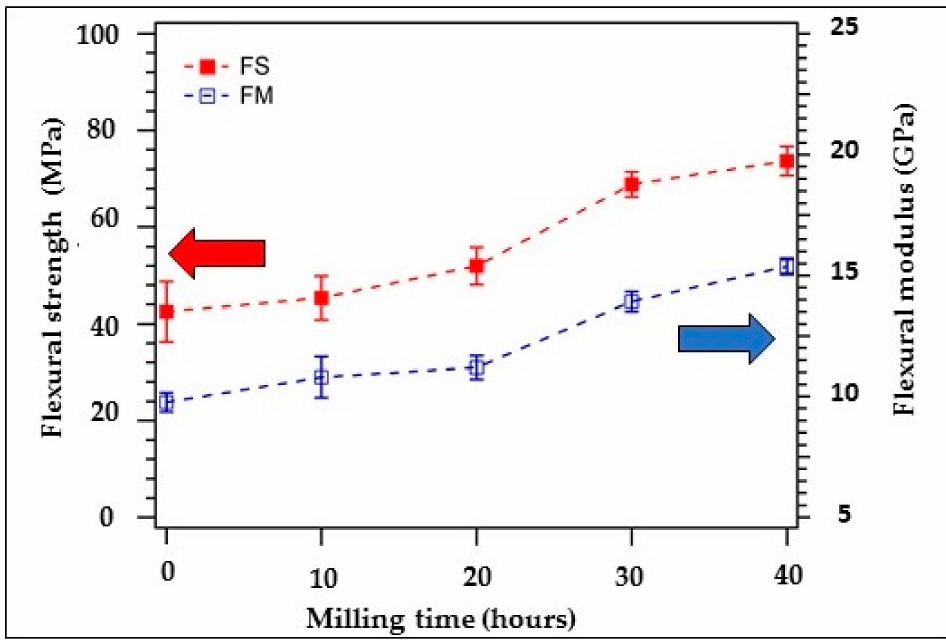
Figure 6. Flexural strength and modulus of the biocomposite for various milling